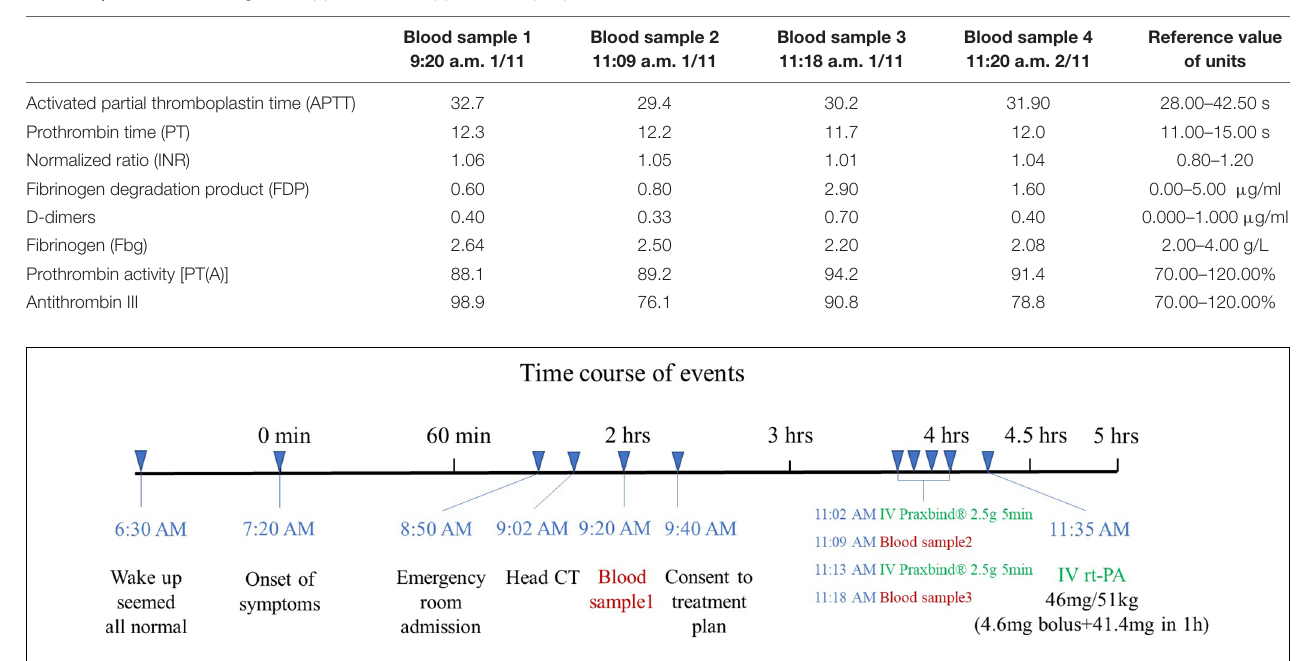
TABLE 1 | Hemostasis testing before (1), in course of (2), and after (3, 4) idarucizumab administration.